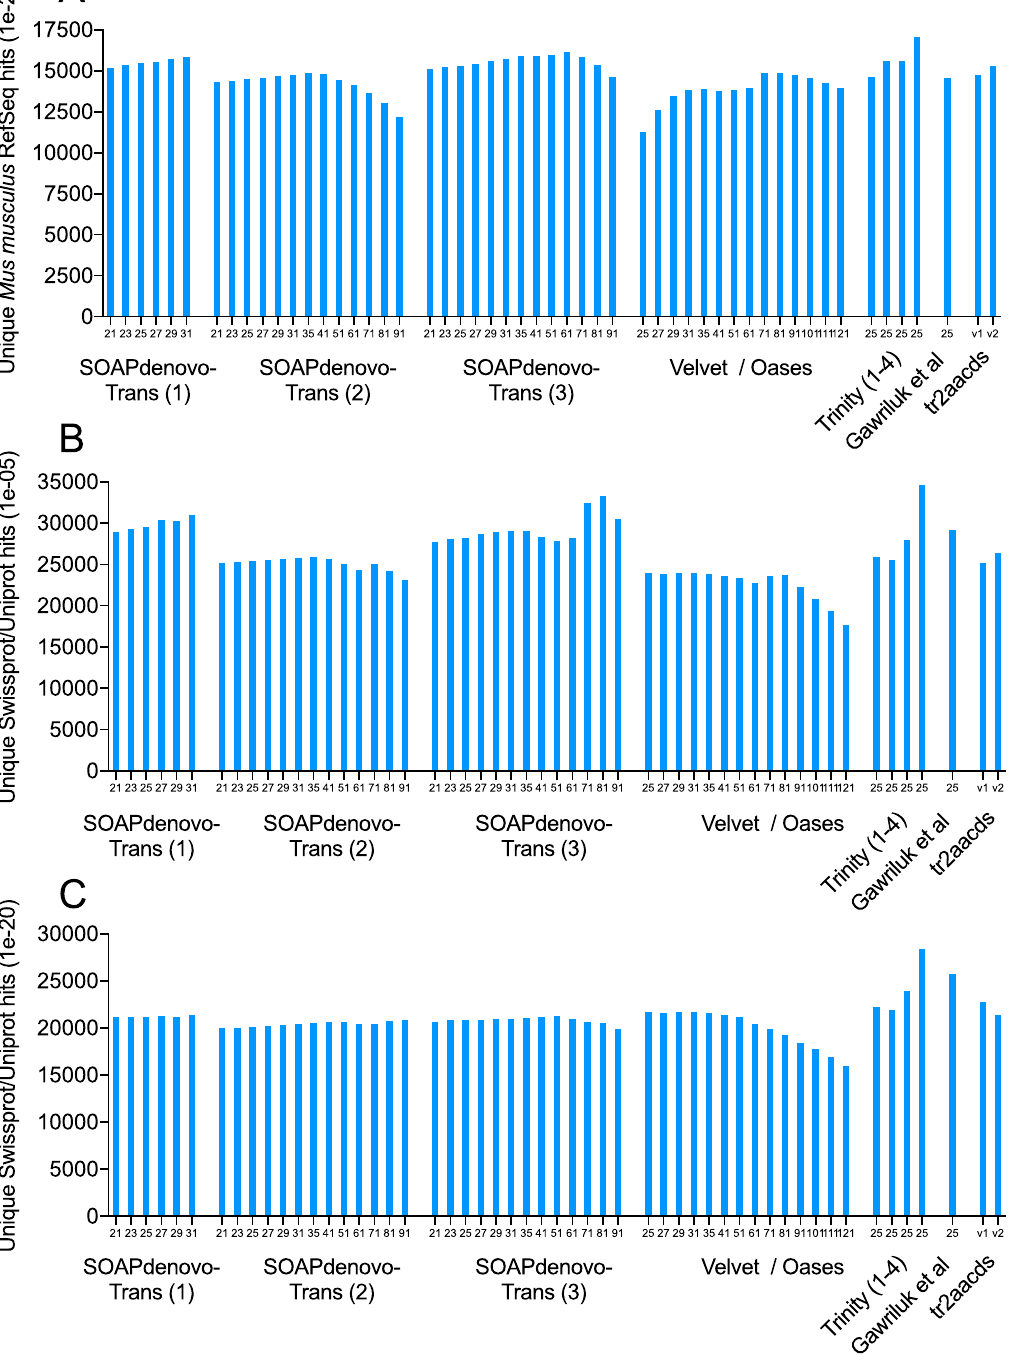
Figure 9. Unique BLAST hits for each assembly when aligned to: ( A ) Mus musculus RefSeq transcript database (e-value ≤ 1 × 10 − 20 ), ( B ) UniProtKB/SwissProt database (e-value ≤ 1 × 10 − 5 ), ( C ) UniProtKB/SwissProt database (e-value ≤ 1 × 10 − 20 ). SOAPdenovo-Trans (1): no filtering; (2): light filtering of poor quality read pairs, combined with in silico normalization; (3): moderate filtering of poor quality read pairs; Trinity (1): light filtering of poor quality read pairs, combined with in silico normalization; (2): moderate filtering of poor quality read pairs; (3): light filtering of poor quality read pairs, combined with SEECER error correction; (4) Trinity v2.3.2 after moderate filtering of poor quality read pairs; tr2aacds merged assemblies (v1): pre-v2.3.2 Trinity; (v2) including v2.3.2 Trinity